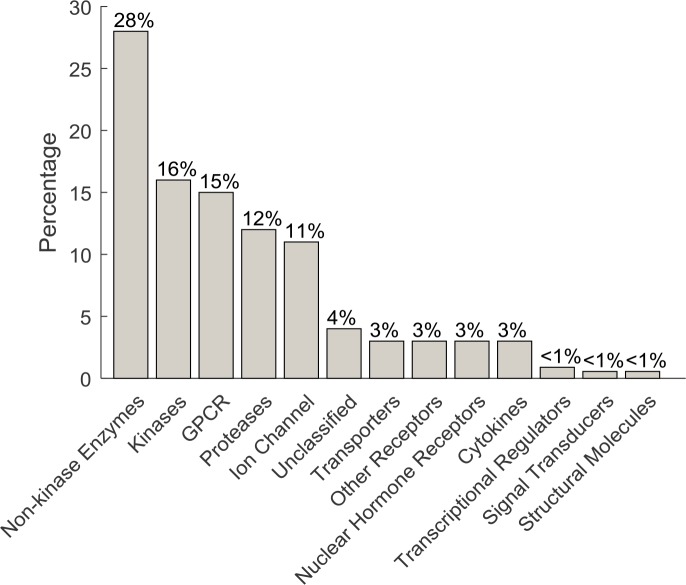
Percentage of the target class coverage of the MOA Box compounds.